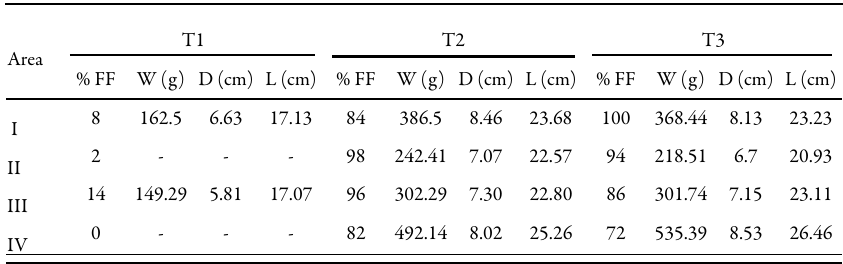
Table 4. Comparisons of the mean weight of fruit set in different tests (T2 and T3) within each study area and comparisons of those values for fruit set in (T2) among those areas (two-way Anova and a posteriori test Tukey HSD t-test; T1 = without insect visitation test; T2 = free insect visitation test T3 = pollen complementation